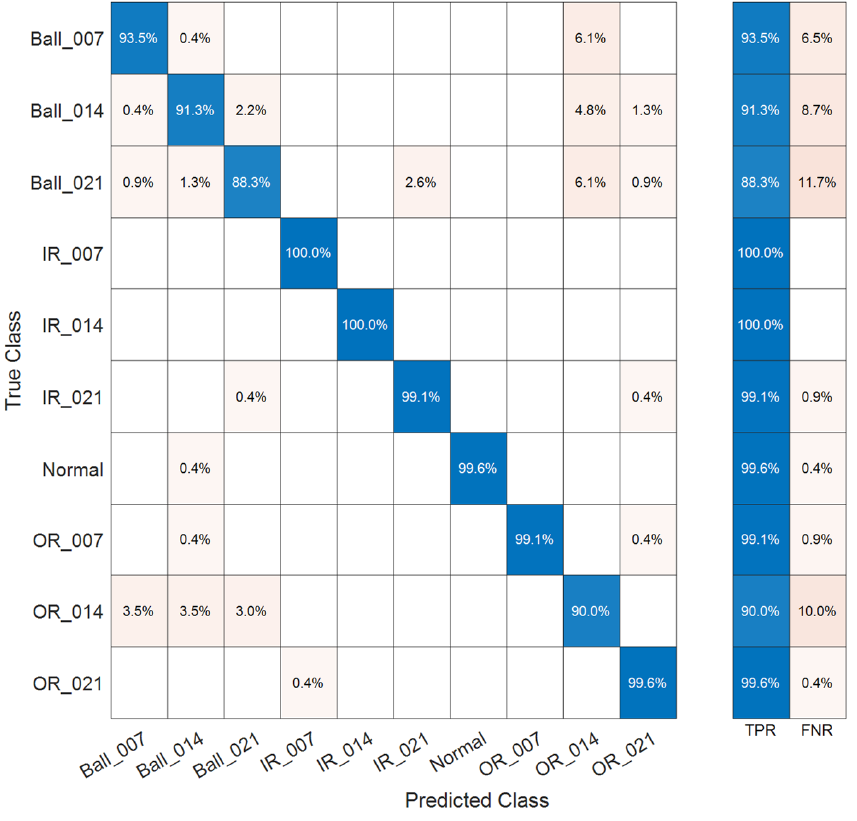
Figure 9. Confusion matrix of motor bearing failure prediction in medium Gaussian SVM, with a total accuracy of 96%.